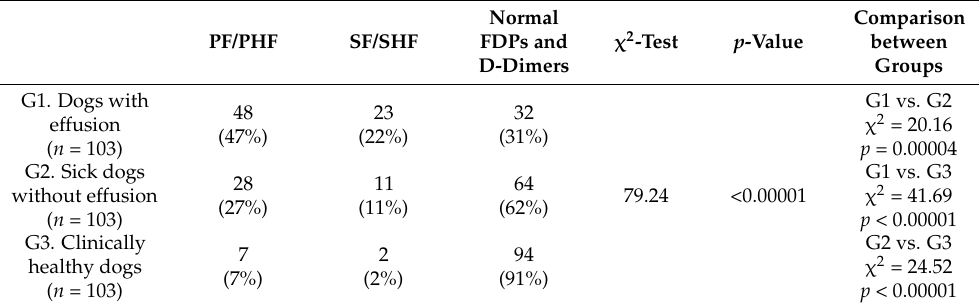
Table 3. Differences in the frequency of PF/PHF, SF/SHF and the absence of fibrinolysis activation in dogs with intracavitary effusion as compared with sick dogs without effusion and clinically healthy control dogs (combined data from studies [41,42]). The sick dogs without effusion and the clinically healthy dogs were individually matched for age, sex, and breed to dogs with intracavitary effusion. Comparison PF/PHF SF/SHF p -Value